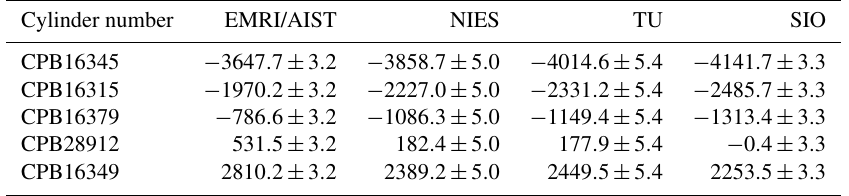
Table 3. δ (O 2 / N 2 ) round-robin values in the round-robin standard mixtures reported by EMRI/AIST, NIES, TU, and SIO.